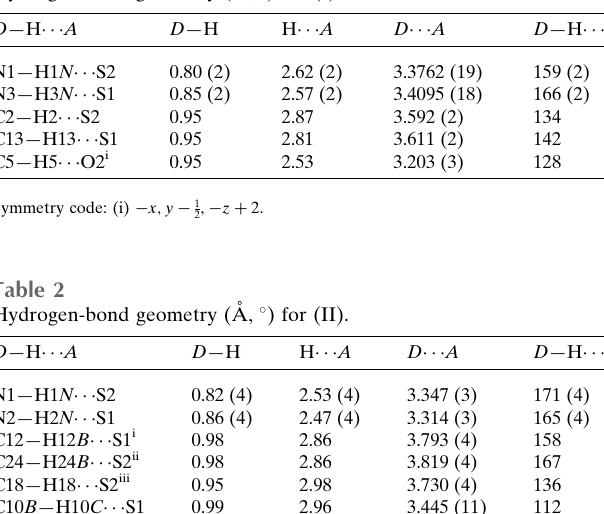
Table 1 Hydrogen-bond geometry (A˚ , (cid:5) ) for (I).